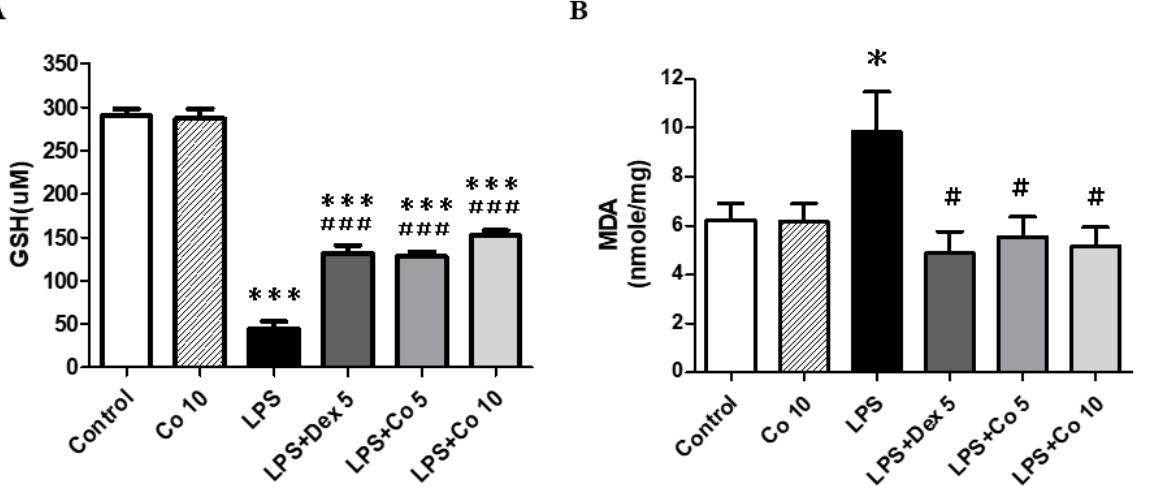
Figure 5. Effects of corilagin on oxidative stress in LPS-induced ALI . After intratracheal LPS challenge for 30 min, the mice were administered with Dex (5 mg/kg), corilagin (5 and 10 mg/kg), or equal volume of saline intraperitoneally. Mice were sacrificed, and lung tissues were obtained after 6 h of LPS challenge. The lung tissue ( A ) GSH and ( B ) MDA levels are expressed as means ± SEM ( n = 6 mice/group). * p < 0.05, *** p < 0.005 vs. control; # p < 0.05, ### p < 0.005 vs. LPS alone.